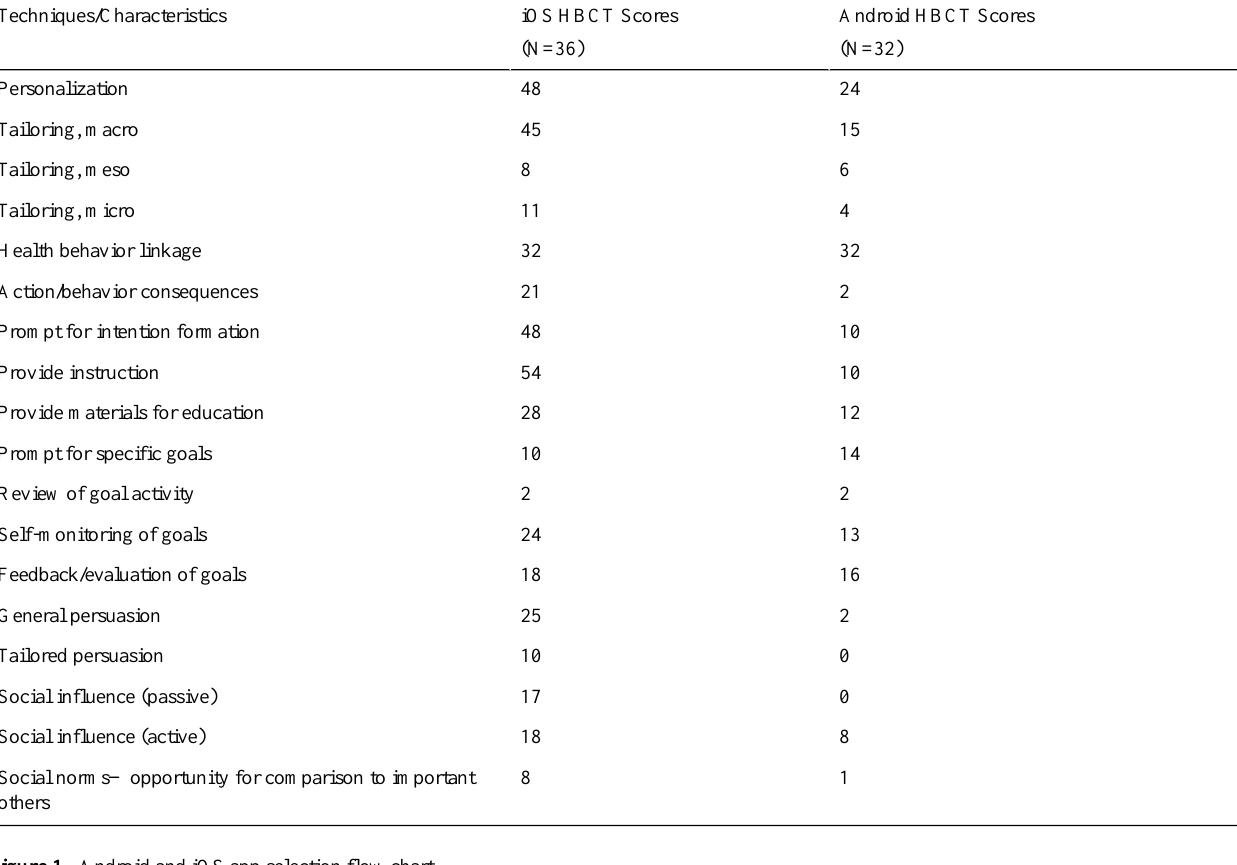
Table 2. Rating totals for health behavior change techniques. Each item was scored as 1=present or 0=not present. Total possible scores for each platform are 72 (2×36) for iOS apps and 64 (2×32) for Android apps based on the use of two raters for each type of app.